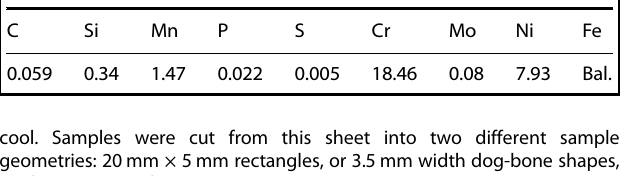
Table 1. Elemental composition of AISI Type 304 stainless steel (weight